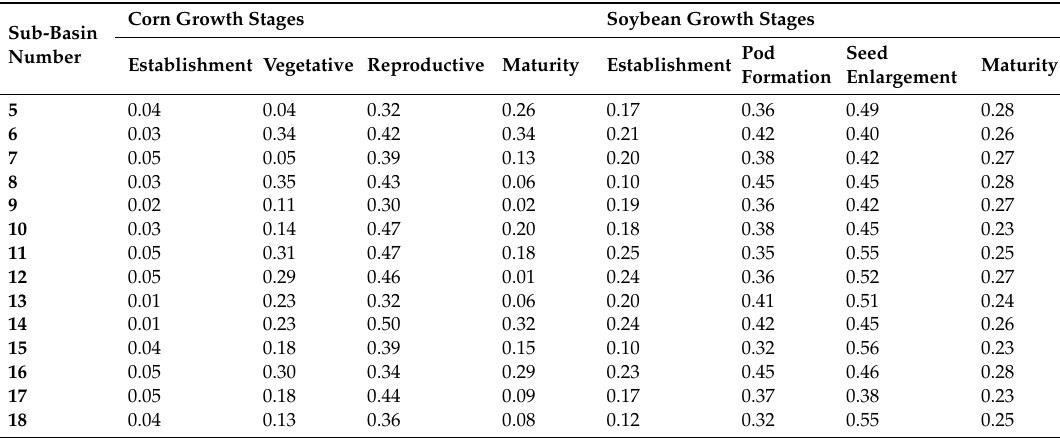
Table 3. Sensitivity indexes of water production